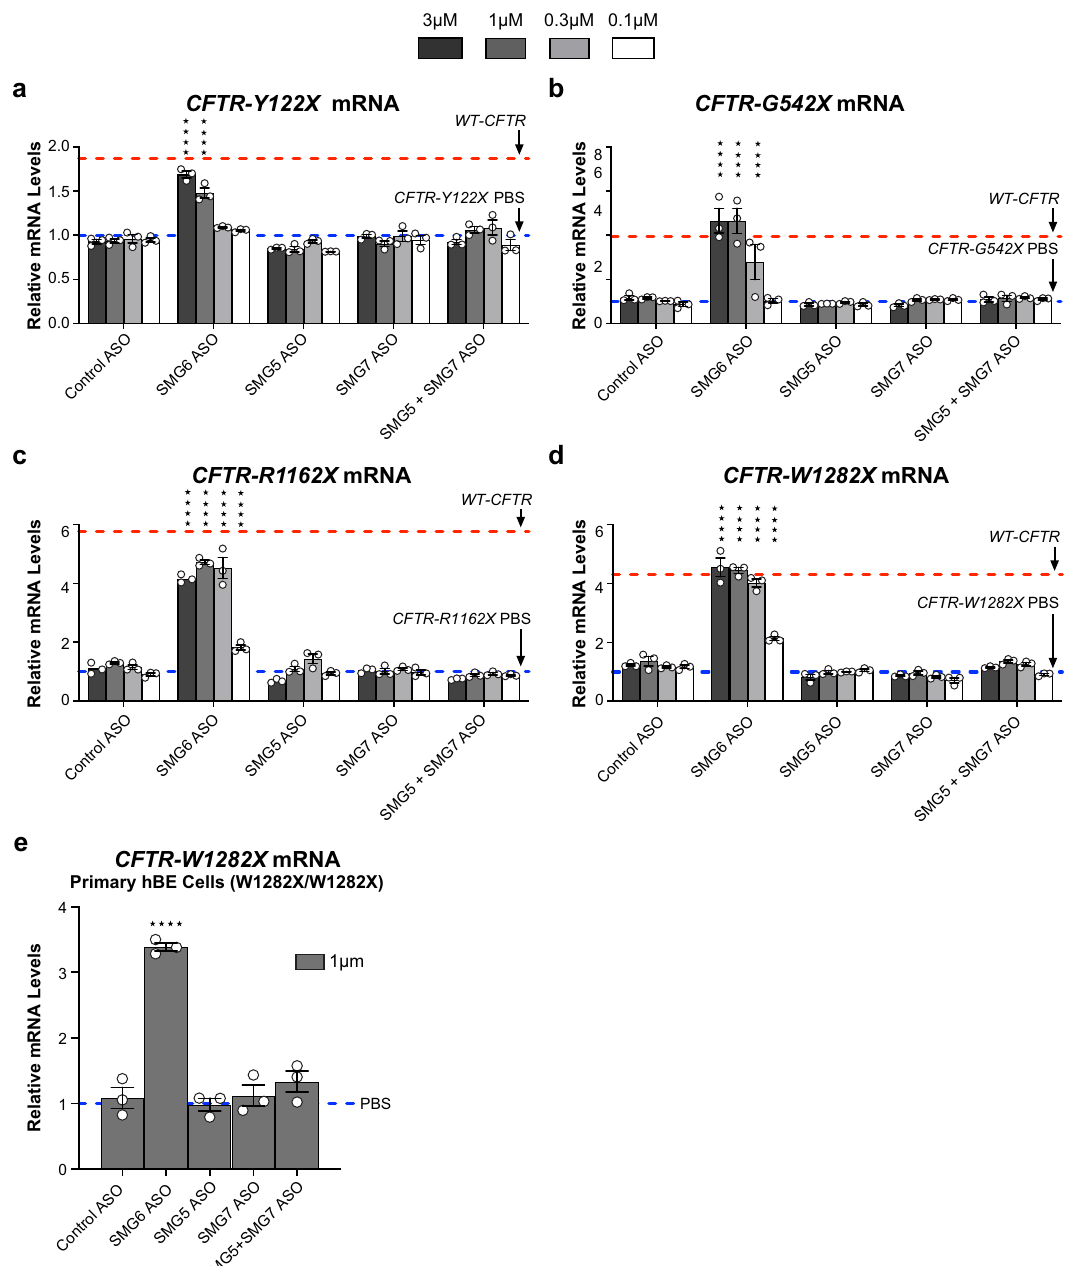
Fig. 5 CFTR mRNA with nonsense codons are degraded by the SMG6-mediated endonucleolytic decay pathway but not the SMG5-SMG7-mediated exonucleolytic decay pathway. RT-qPCR analysis of CFF-16HBEge cells with ( a ) Y122X, ( b ) G542X, ( c ) R1162X, or ( d ) W1282X CFTR nonsense mutations treated with ASOs targeting SMG6 , SMG5 , or SMG7 . e RT-qPCR analysis of CFTR mRNA levels in hBE cells homozygous for the W1282X nonsense mutation treated with ASOs targeting SMG6 , SMG5 , or SMG7 . Cells treated with PBS or a scrambled control ASO were used as negative controls. CFTR mRNA levels were normalized to total RNA levels in CFF-16HBEge and hBE cells. CFTR mRNA levels were also normalized to housekeeping gene β -actin mRNA (Supplementary Fig. 7b). PBS control levels for CFTR mRNA expression were set to 1 and are indicated by blue dotted lines. Wild-type (WT) CFTR mRNA levels from parental cells are indicated by red dotted lines. n = 3 for each group. Data are presented as mean ± SEM from biologically independent samples. Statistical signi fi cance was analyzed by ( a – d ) two-way ANOVA or ( e ) one-way ANOVA followed by Dunnett ’ s multiple-comparison test (**** p < 0.0001). See Source Data fi le for the exact p -values. Source data are provided as a Source Data fi